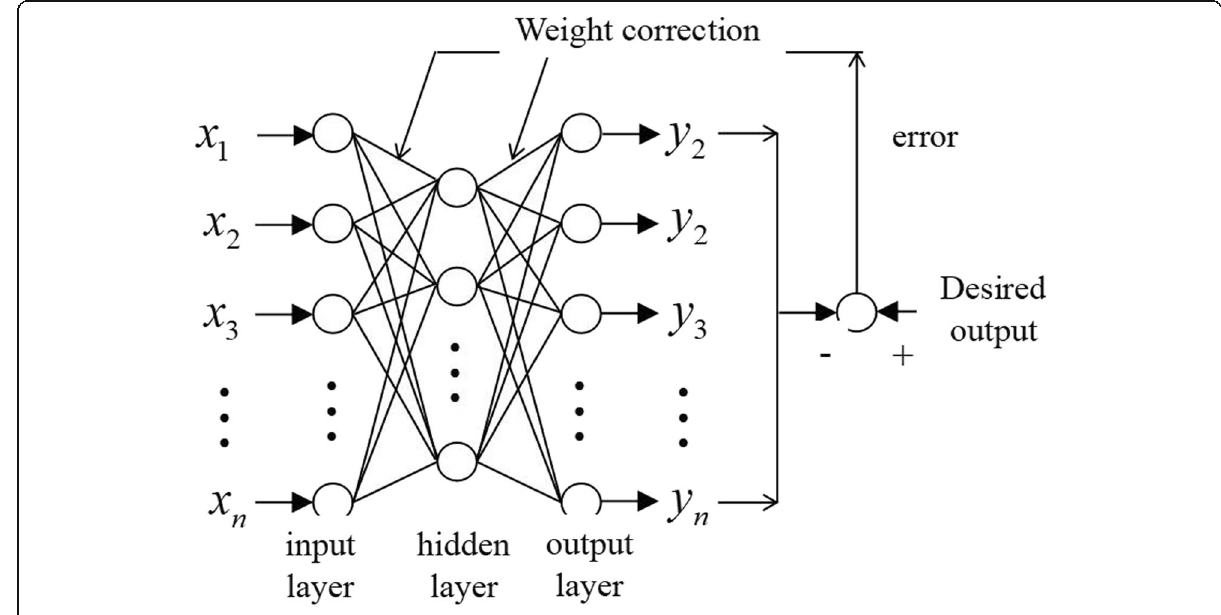
Fig. 1 Structure of BP neural